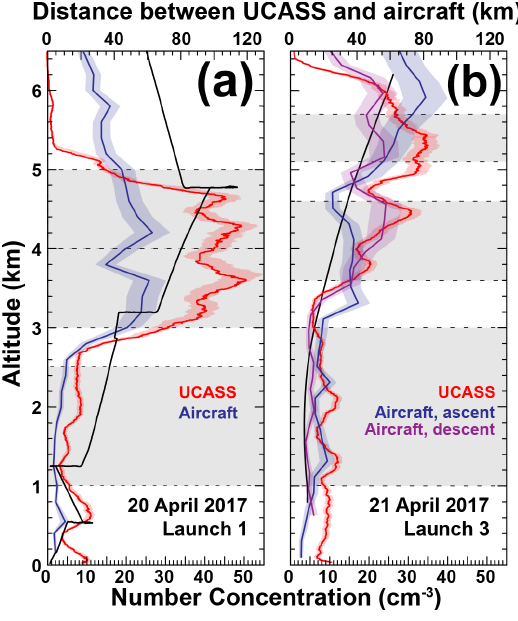
Figure 5. Total number of particles in the diameter range from 0.6 to 13.9µm counted by UCASS (red) and with the CAPS (CAS) instru- ment aboard the Falcon aircraft (blue and purple, size range from 0.79 to 14.0µm; shading marks the standard deviation obtained as median minus 25th percentile and 75th percentile minus median) measured (a) during the first UCASS launch on 20 April 2017 and (b) during the third UCASS launch on 21 April 2017. Red shaded areas refer to the effect of a counting uncertainty of 8% ( y error) as stated in Smith et al. (2019). The black lines mark the horizontal dis- tance between the location of the observations from the UCASS and aircraft. Grey areas refer to the height layers considered in Fig.